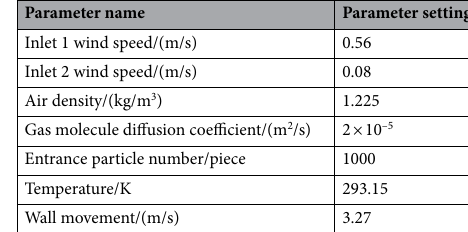
Table 1. Solution model parameters and boundary condition